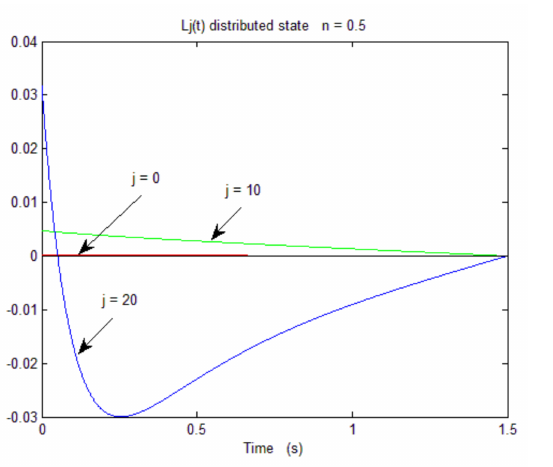
Figure 3. Distributed z ( ω , t ) states.